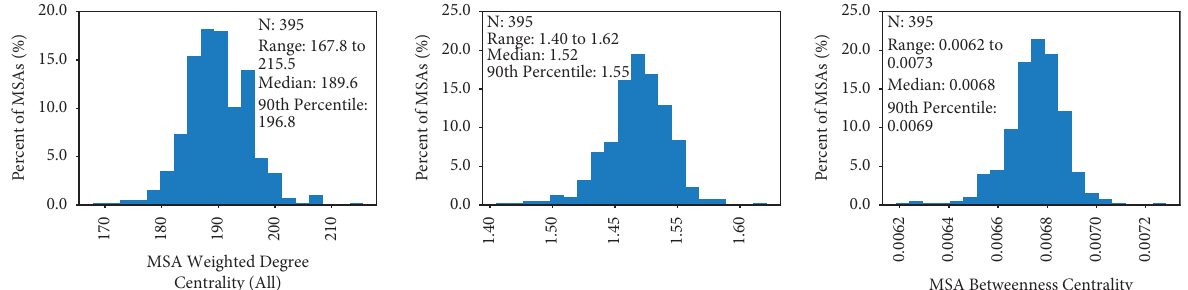
Figure 4: MSA skill centrality distributions.